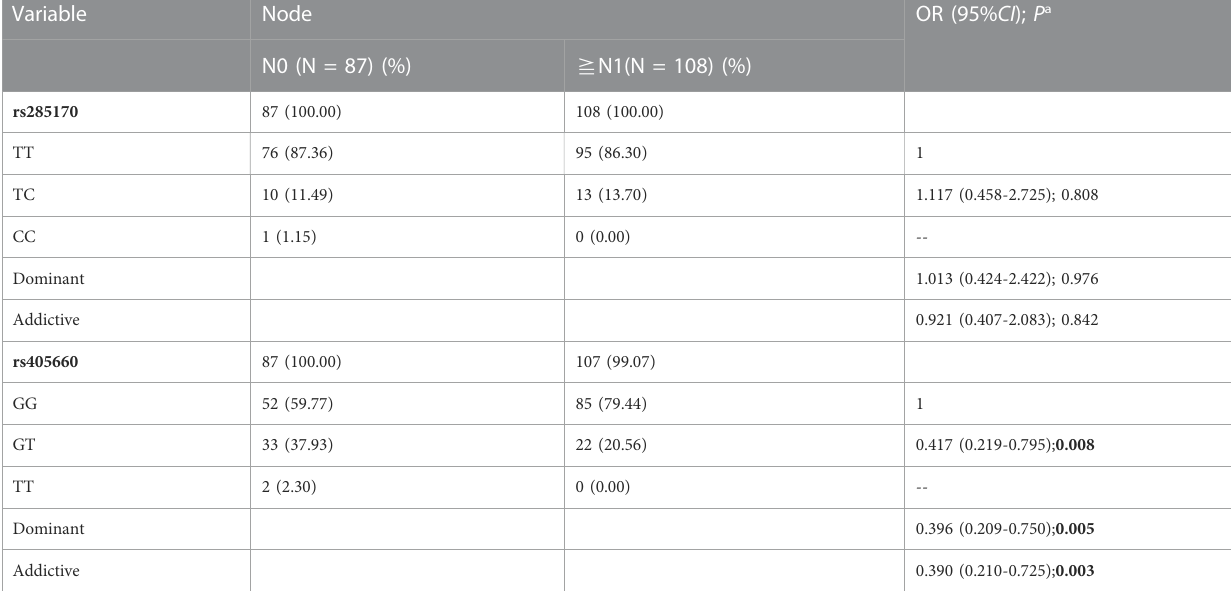
TABLE 6 Association of MYBL2 AS-related genetic variants with TNBC N staging.